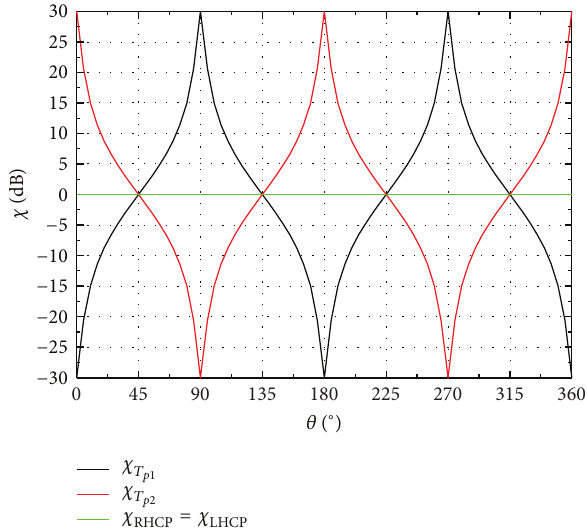
Figure 5: Comparison of signal power balance between linear polarized antenna and circular polarized antenna.